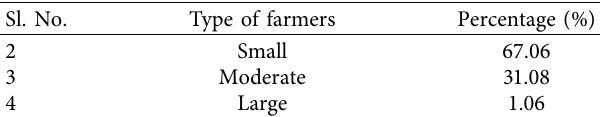
Table 2: Detail of type of farmers. Sl. No.